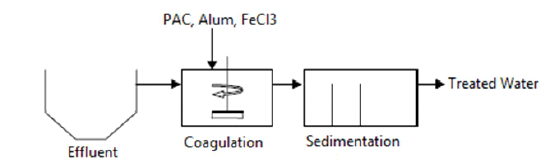
Figure 1. Schematic diagram of the pilot scale plant